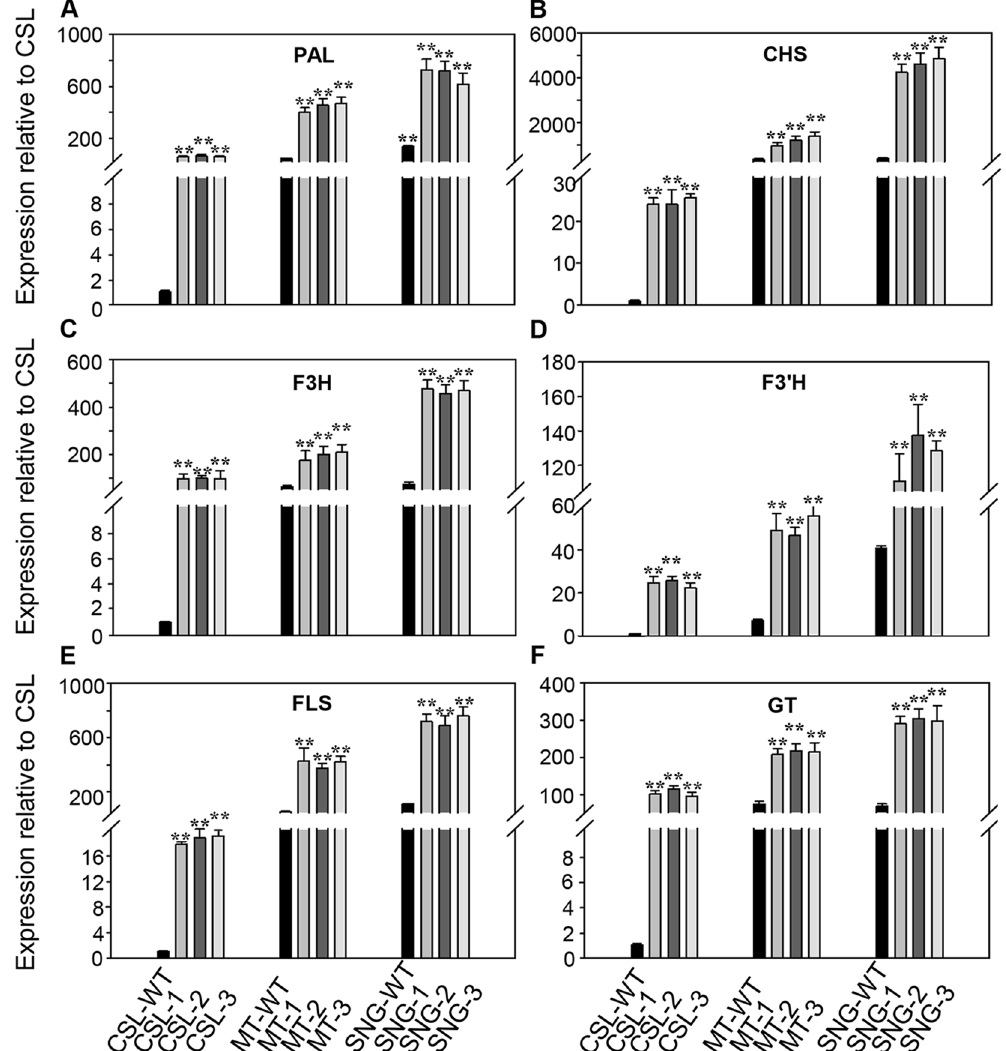
Figure 6. Analysis of transcript levels of the main genes in flavonol metabolism in wild-type and SlMYB12 - overexpressing tomatoes by qRT-PCR. Analyzed genes are described in Fig. 1. ( A ) PAL, phenylalanine ammonialyase; ( B ) CHS, chalcone synthase; ( C ) F3H, flavanone-3-hydroxylase; ( D ) F3 ′ H, flavonoid-3 ′ - hydroxylase; ( E ) FLS, flavonol synthase; ( F ) GT, flavonol-3-glucosyltransferase. Two or three fruits were sampled from each plant. Each value was normalized to the gene expression in cultivar CSL (wild-type) and is indicated as the mean ± standard deviation of three experimental replicates. CSL-WT, Csl03-09 wild-type; MT-WT, Micro-Tom wild-type; SNG-WT, Sheng Nv-Guo wild-type. CSL-1, CSL-2, CSL-3, MT-1, MT-2, MT-3, SNG-1, SNG-2, and SNG-3 indicate the T 1 heterozygous lines of each variety. ** P <